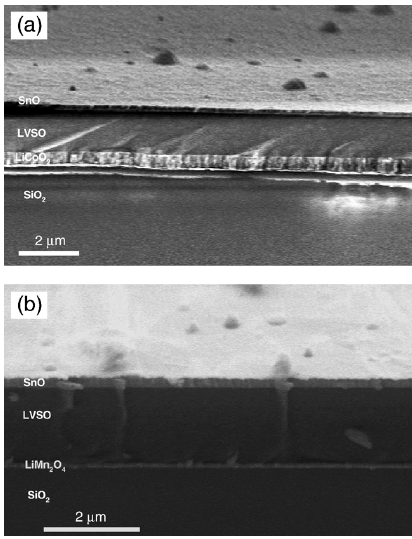
Figure 15. SEM cross-sectional images of solid-state thin film lithium batteries, ( a ) SnO / LVSO / LCO and ( b ) SnO / LVSO / LMO. (Reproduced with permission from [121]. Copyright 2006 Elsevier).